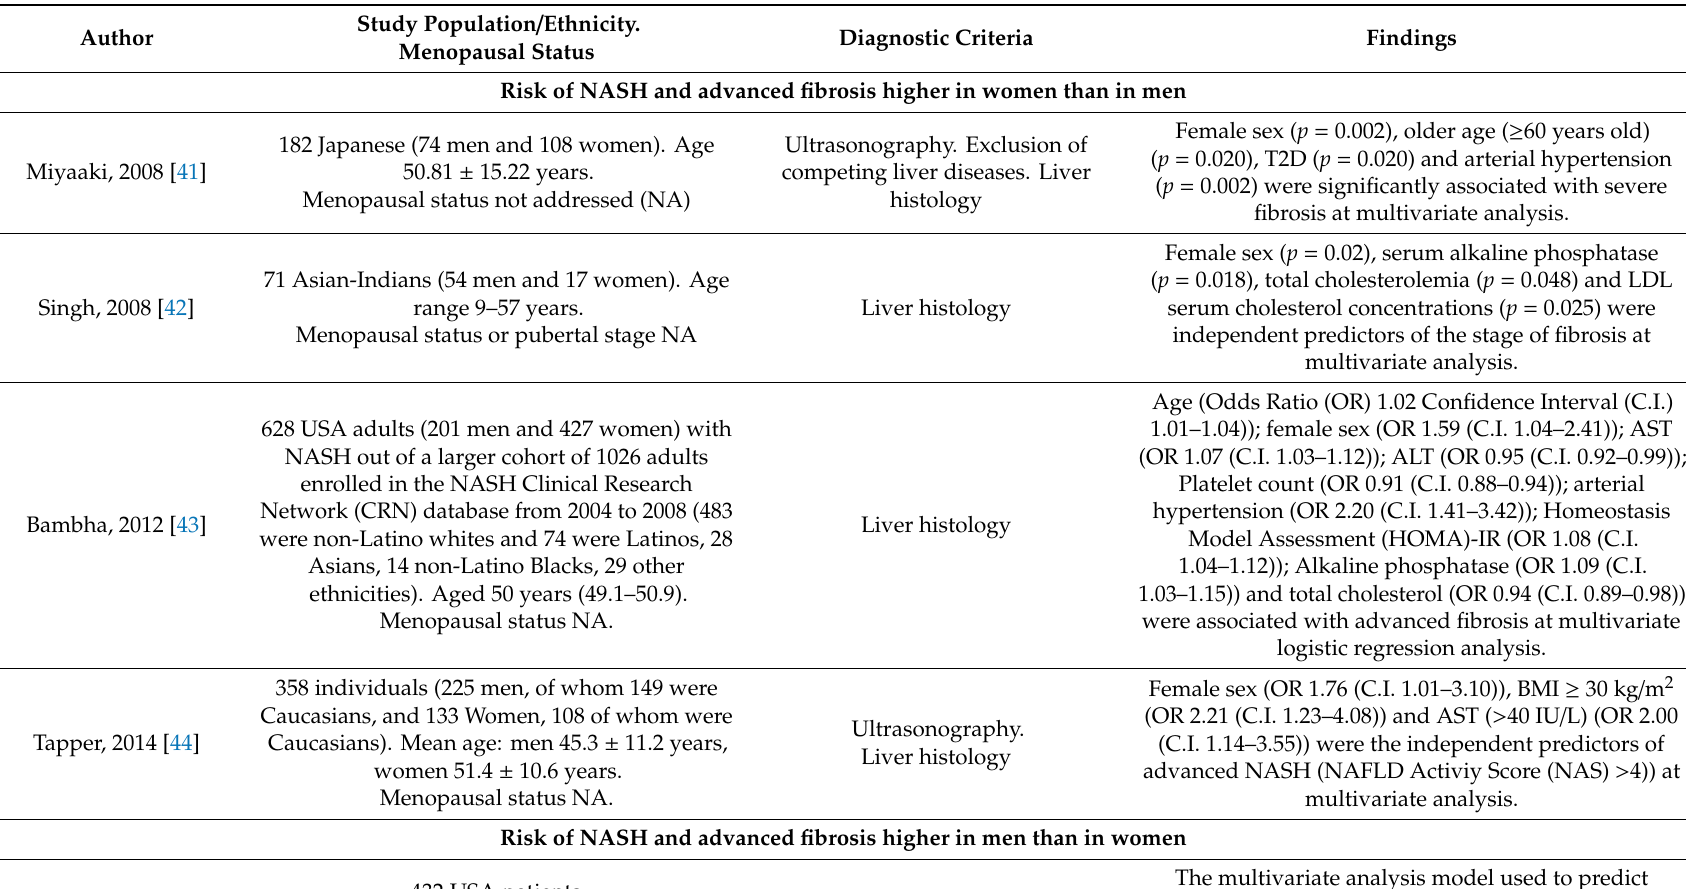
Table 2. Conflicting findings regarding sex as a risk factor for fibrosis in clinical observational